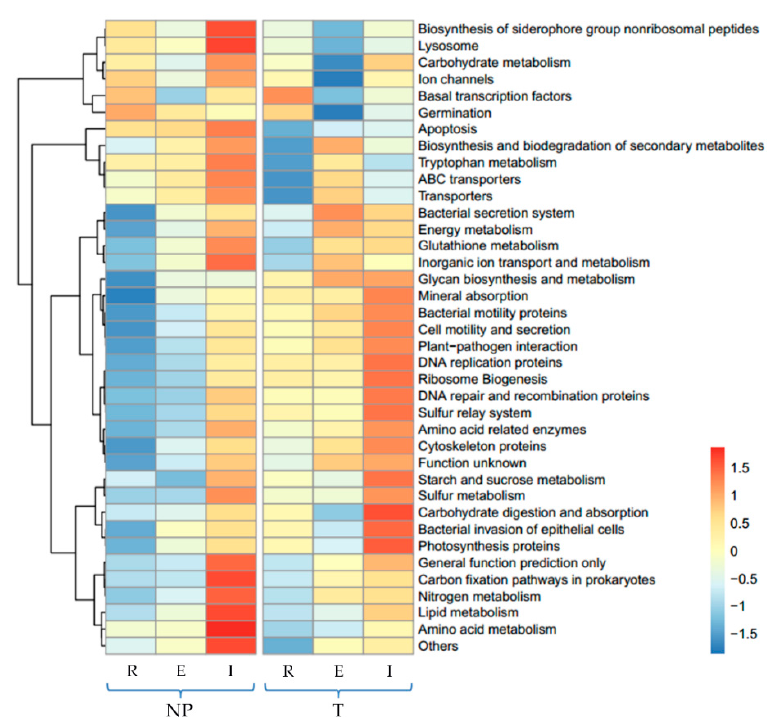
Figure 3. The heatmap of the relative abundance of some functional gene families of the internal layer (I) and external layer (E) of iron plaque and the rhizosphere (R) in non-polluted soil (NP) and tailing soil (T) predicted by PICRUSt.